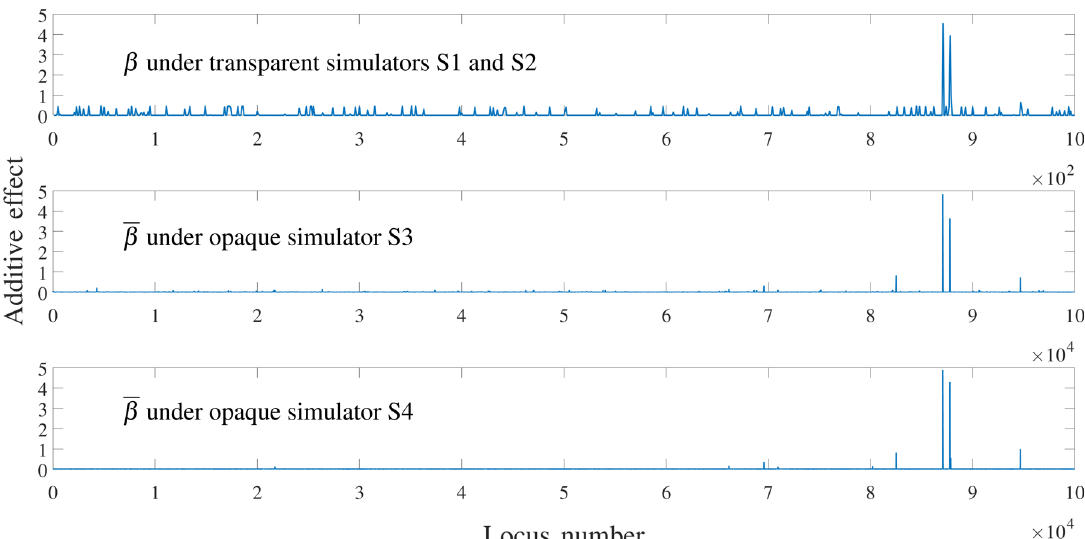
Figure 5. Assumed ground truth additive effects in the four